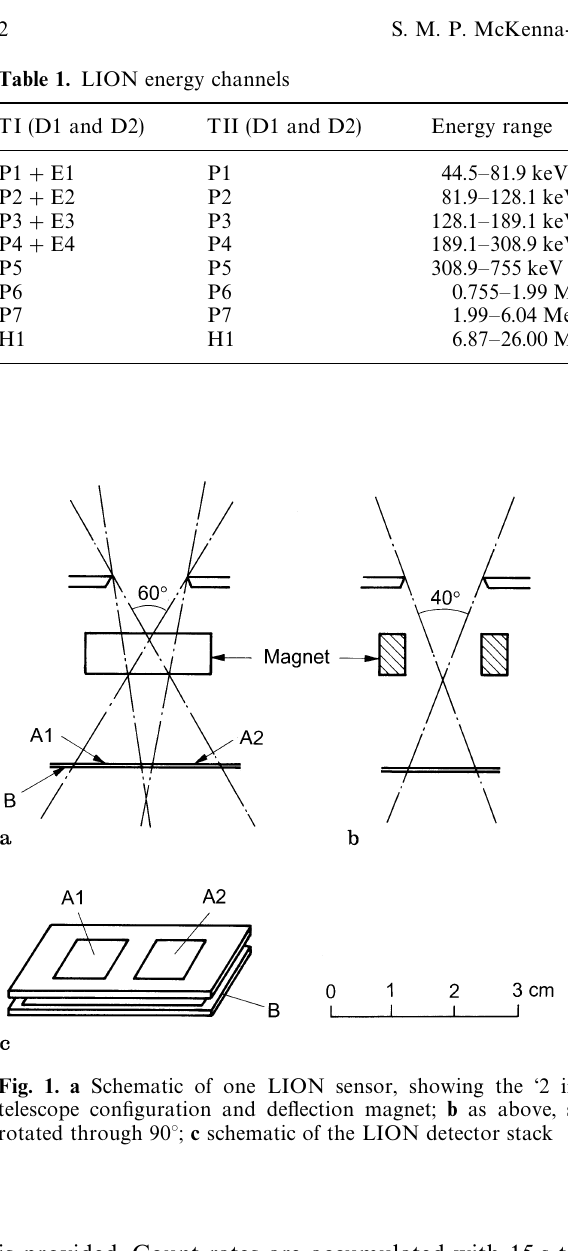
is provided. Count rates are accumulated with 15 s time resolution (counter saturation occurs at 10 (cid:54) counts/15